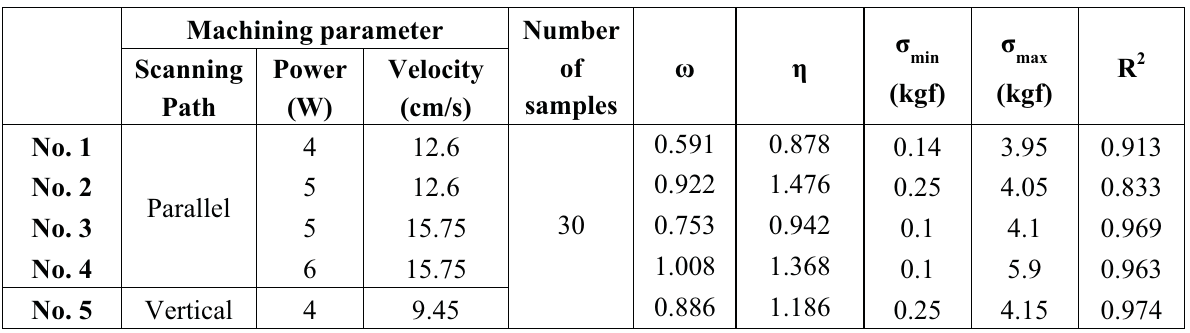
Table 5. Weibull tensile test results.